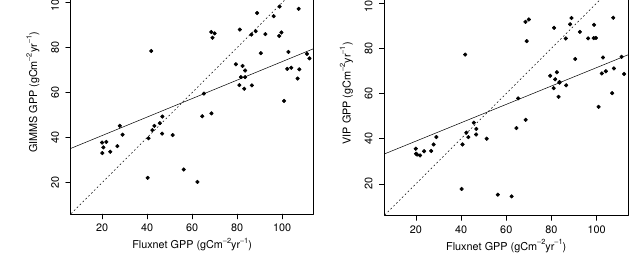
Figure 2. Relationship between the annual GPP recorded at the flux tower sites and the corresponding values of the satellite-derived GPP. The black solid line is the line of best fit and helps better un- derstand the relationship between the two. The dashed line is the 1 : 1 line and demonstrates how much the relationship between the two sets of values deviates from the 1 : 1 perfect relationship.